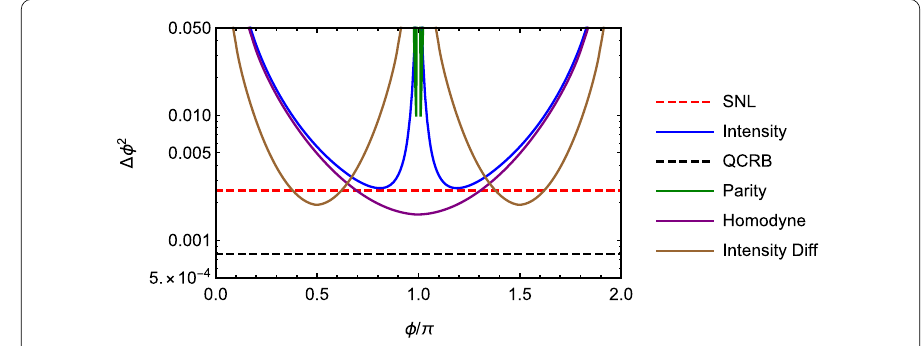
Figure 5 Log plot of phase variance of the various detection schemes, with introduction of thermal photon noise into both interferometer arms, of total average photon number of n th = 1. Strength of the two input sources are set to | α | 2 = 500, r = 1. Note that homodyne loses most of its previous advantage over intensity difference but remains the superior measurement